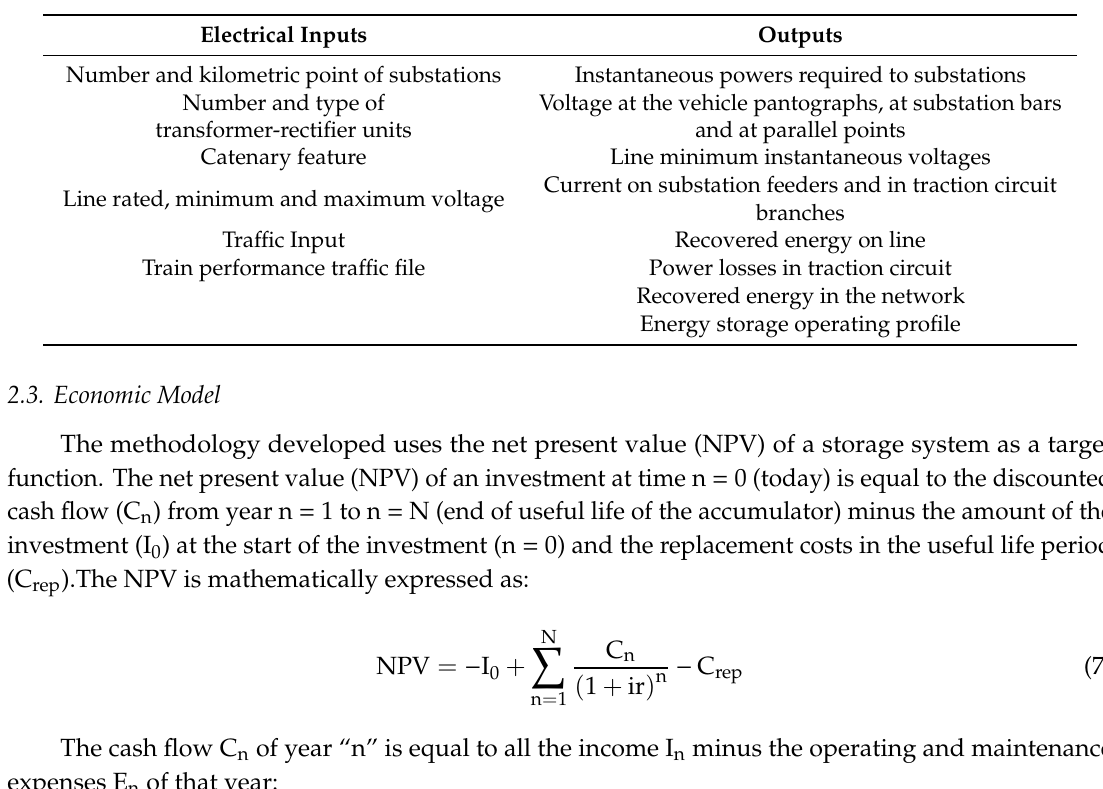
Table 2. Inputs and outputs of traction system